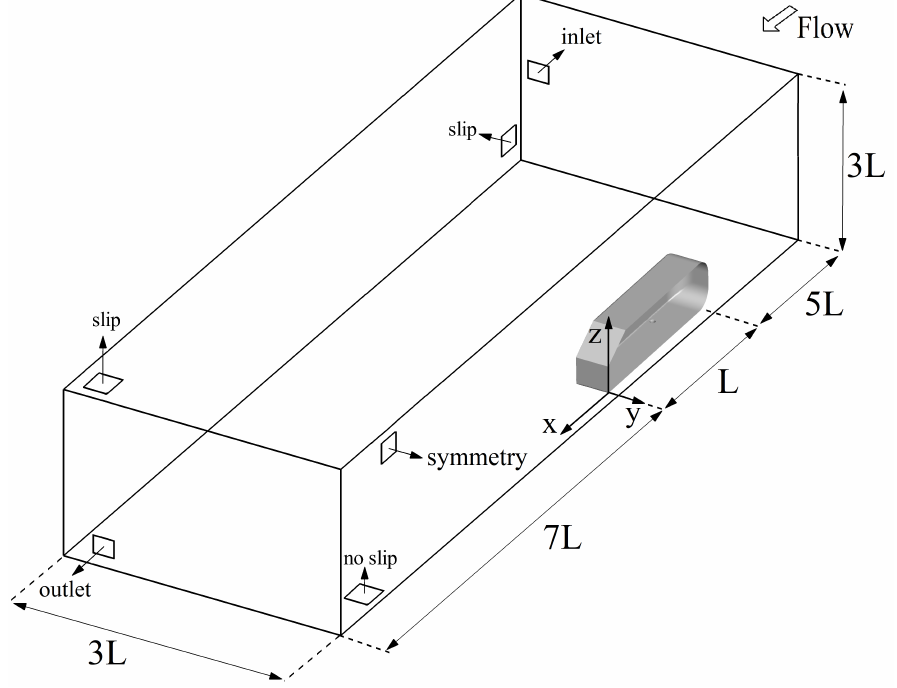
Figure 1. Computational domain (not to